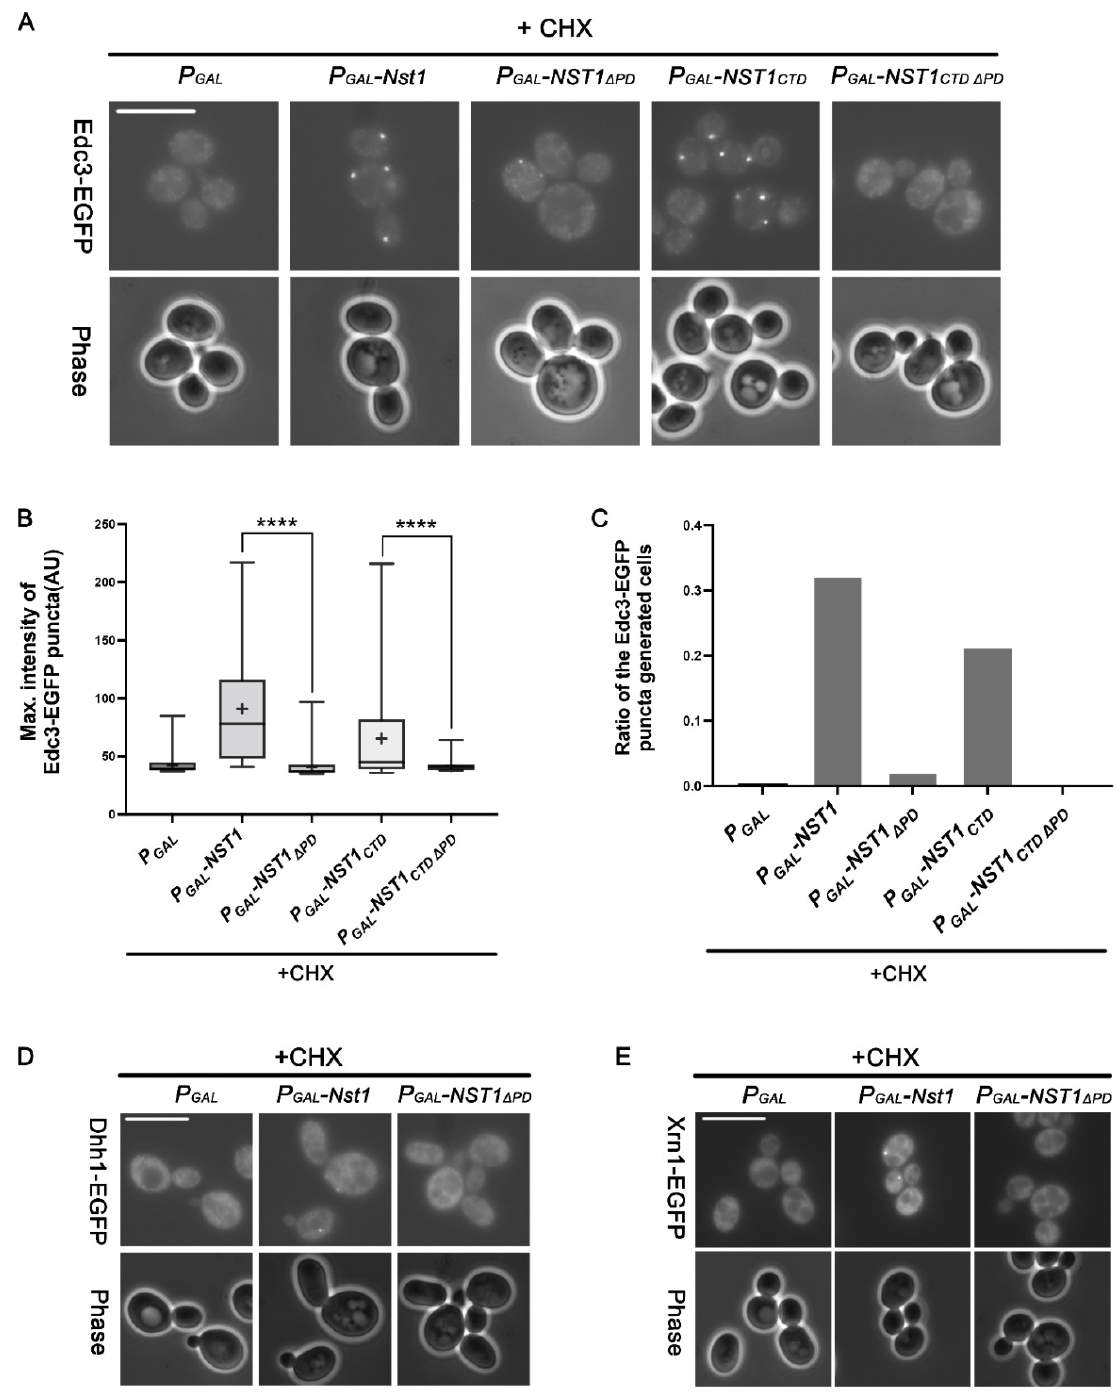
Figure 6. The Nst1 polyampholyte region functions as a binding hub for P-body (PB) components independent of the free ribosomal RNA influx. ( A – C ) In the wild-type strains whose chromosomal EDC3 was tagged with EGFP, the full-length Nst1, Nst1 Δ PD (residues 1–630 and 753–1240), Nst1 CTD (C-terminal Nst1 residues 430–1240), and Nst1 CTD Δ PD (residues 431–630 and 753–1240) were overexpressed. Endogenous enhancer of mRNA decapping 3 (Edc3) was observed before and after cells were treated with 100 μ g/mL CHX for 10 min . ( A ) Fluorescence microscopy of EGFP-Edc3 in the cells overexpressing each mutant before and after the 10 min 100 μ g/mL CHX treatment. Scale bar: 10 μ m. ( B ) Quantification of the EGFP-Edc3 puncta shown in ( A ) with CHX. The pixels of the top 0.1% signal intensities were segmented as the EGFP-Edc3 puncta. The EGFP-Edc3 puncta generated were quanti- fied, and the maximal value of each punctum was plotted. ‘+’ in the boxplot indicates the mean value